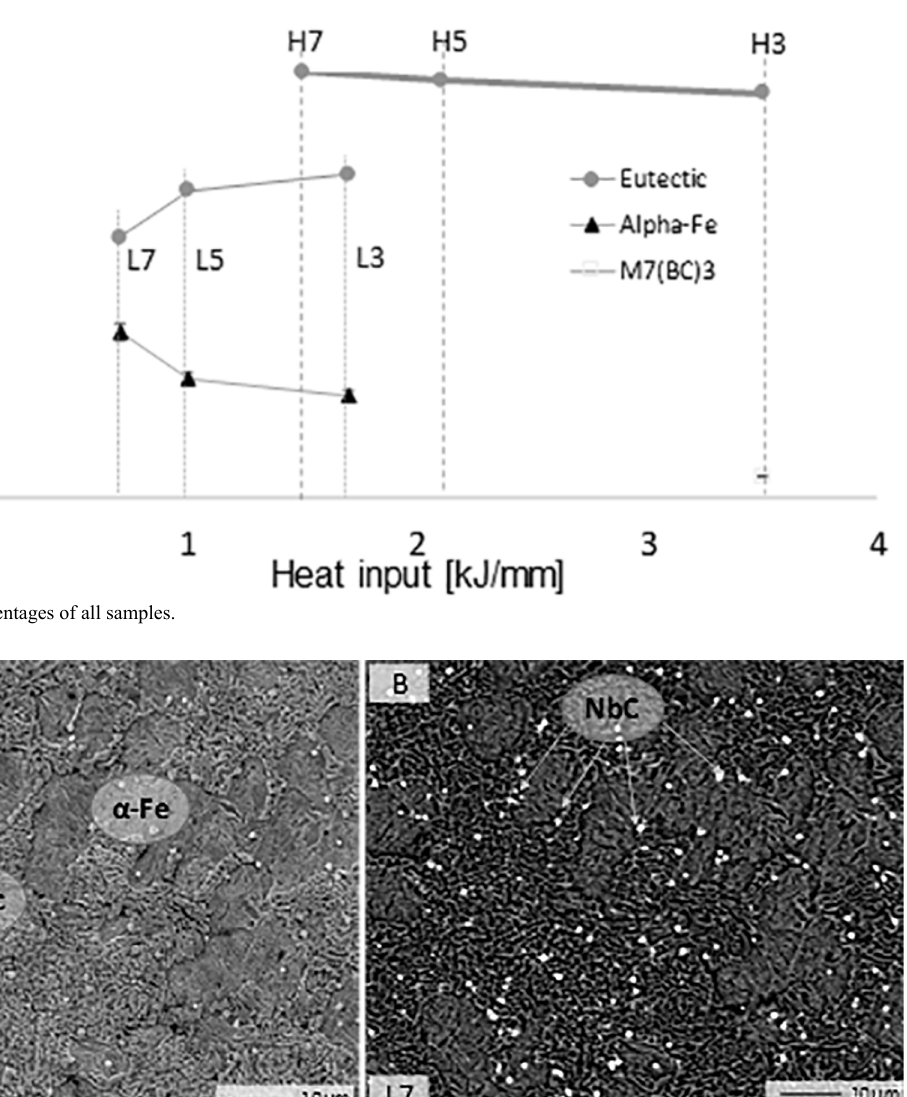
The microhardness of the eutectic phase varied from 830 HV for H3 to 920 HV for L7. A linear